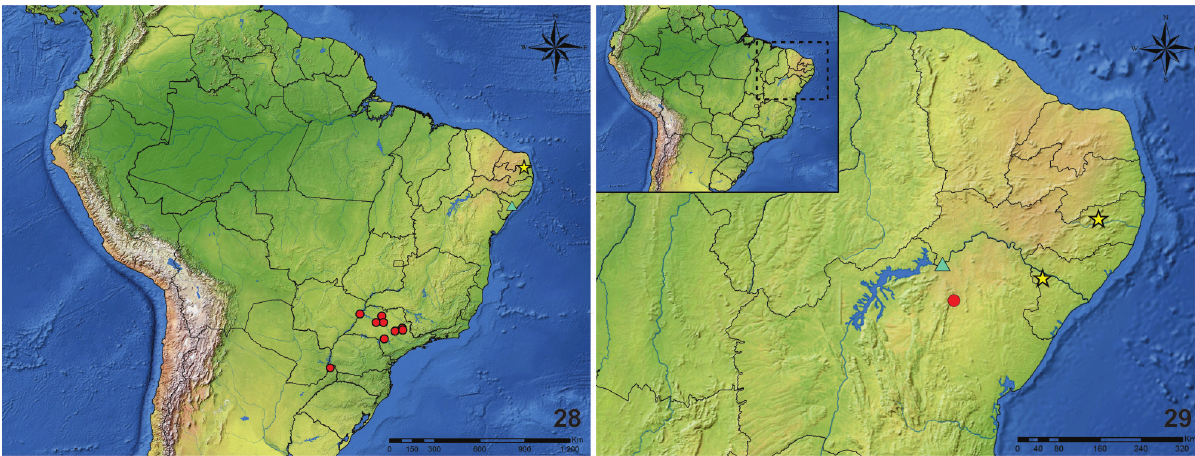
Figures 28–29. (28) Distribution map. Iguazus ornithopus = red circles; I. roseofasciatus = blue triangle; I. robustus sp. nov. = yellow star. Locality data for I. ornithopus and I. roseofasciatus taken from the literature. (29) Distribution map. Tessarithys neoecobius = red circle; T. machaerophorus = blue triangle; T. soledadinus = ?; T. exacuminatus sp. nov. = yellow stars. Locality data for T. neoecobius and T. machae- rophorus taken from the